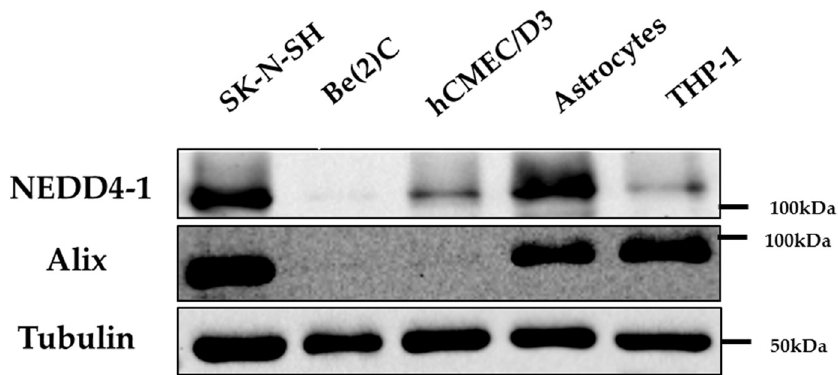
Figure 1. Expression of Apoptosis-linked gene 2-interacting protein X (Alix) and Neural precursor cell-expressed developmentally downregulated gene 4 (NEDD4-1) protein in various cell lines. Immunoblots of Alix and NEDD4-1 protein expression in cell lines as listed in Materials and Methods (6 µg cell protein loaded per lane).